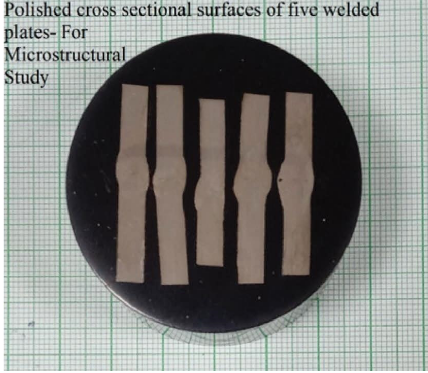
Figure 3: Five polished samples for microscopic analysis. Figure